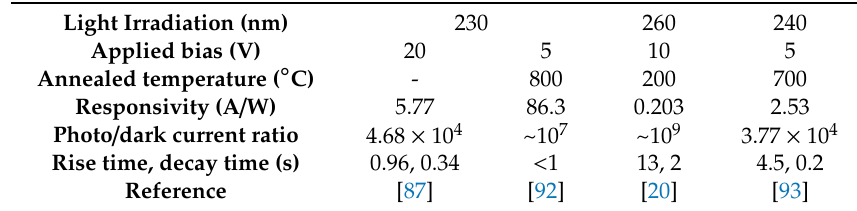
Table 8. Optimized performances of photodetectors in the four references.